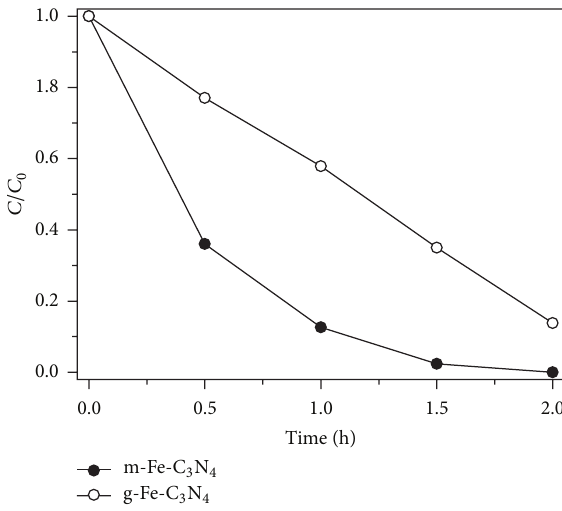
Figure 7: Comparison of the activities of g-Fe-C 3 N 4 and m-Fe-C 3 N 4 samples for RhB photocatalytic